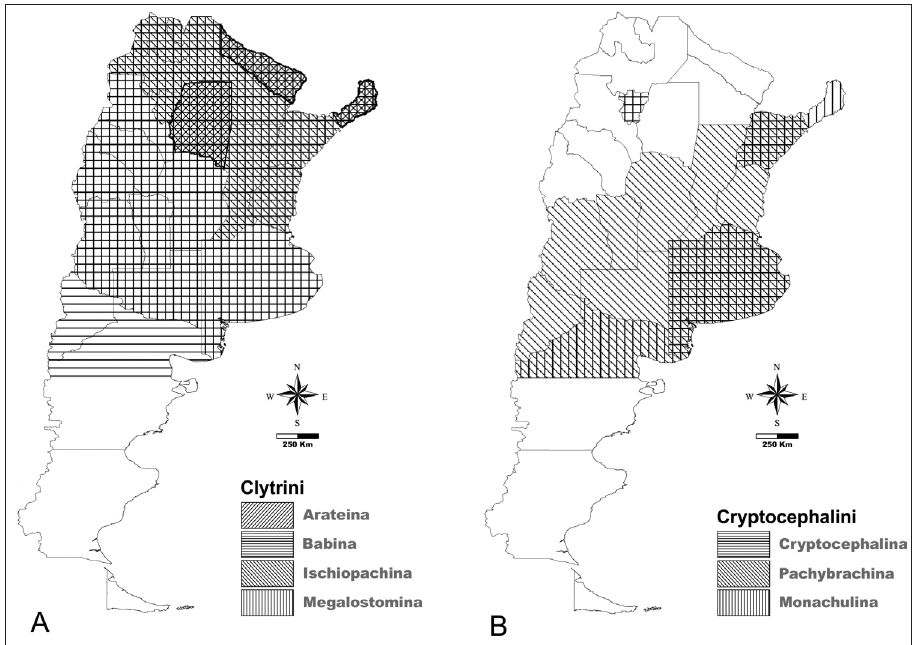
Figure 35. A Administrative divisions representing presence of subtribes of Clytrini as indicated in refer- ence B Administrative divisions indicating presence of subtribes of Cryptocephalini as indicated in